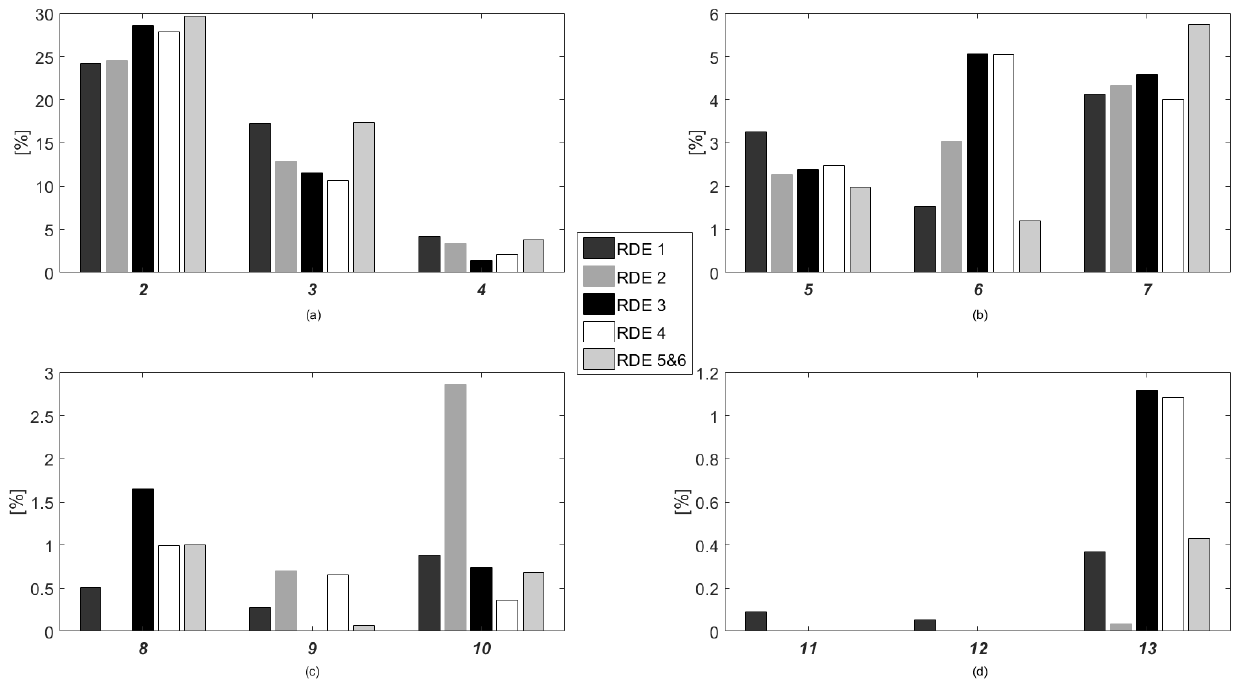
Figure 6. Bin proportions from 2 to 4 (a), 5 to 7 (b), 8 to 10 (c) and 11 to13 of each cycle. Looking at RDEs 3 and 4, and the bins that represent the urban area (3, 6, 9, and